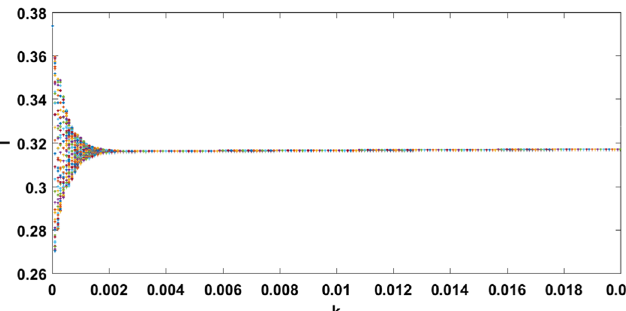
Fig. 6 A bifurcation diagram for the infected population (I) with respect to the parameter